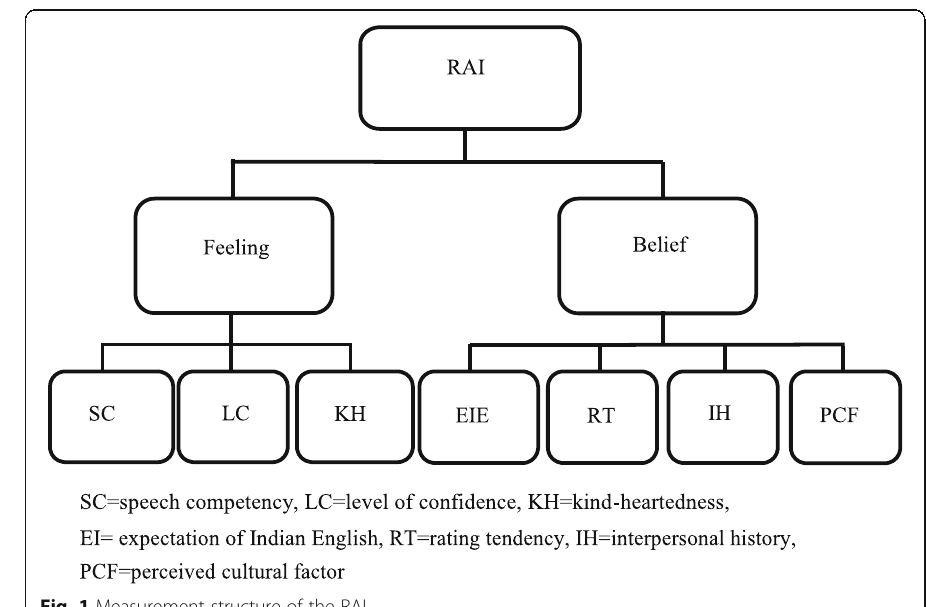
Fig. 1 Measurement structure of the